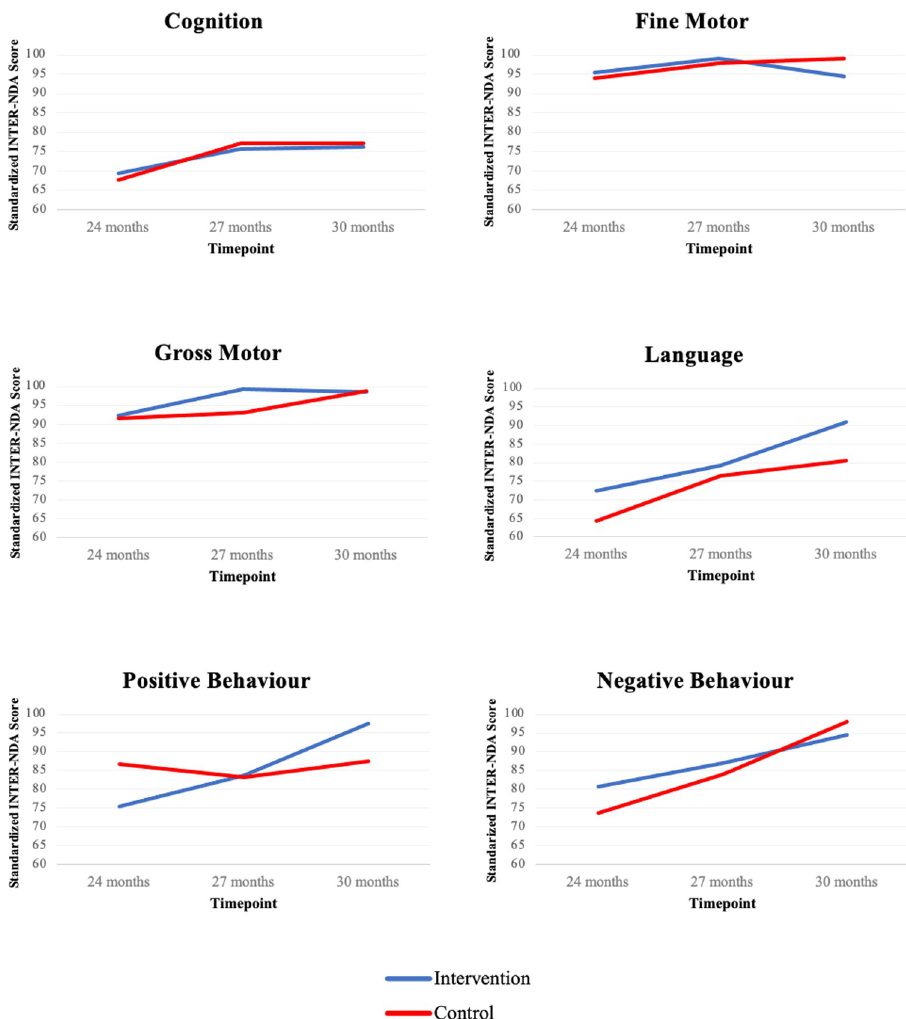
Fig 2. Fitted GEE Model Plots of Child Development Domains Over Time by